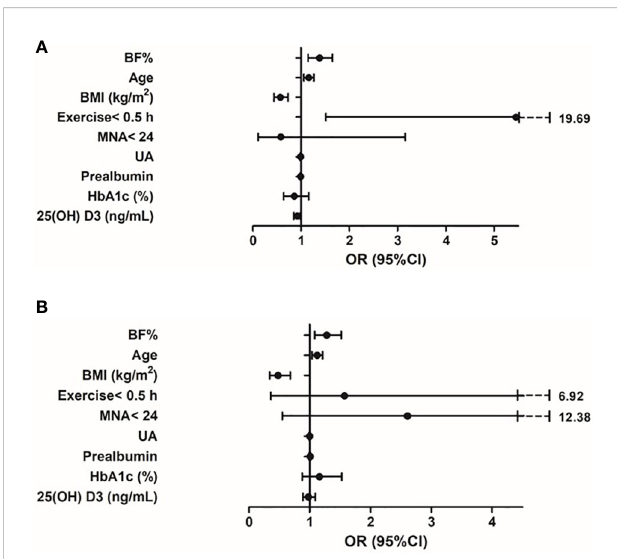
FIGURE 3 (A) Variables associated with sarcopenia in older adults with diabetes (male). Logistic regression model adjusted for BF%, age, BMI, exercise< 0.5 h, MNA<24, UA, prealbumin, HbA1c, 25(OH) D3. (B) Variables associated with sarcopenia in older adults with diabetes (female). Logistic regression model adjusted for BF%, age, BMI, exercise< 0.5 h, MNA<24, UA, prealbumin, HbA1c, 25(OH) D 3